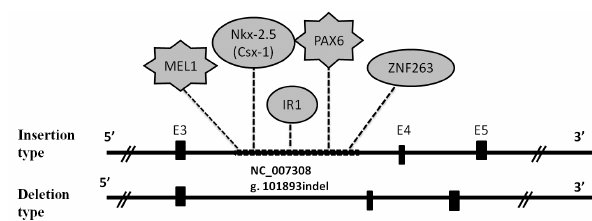
Figure 4. Prediction of transcription factor binding sites in the SMAD3 gene 17 bp indel sequence. MEL1 : MDS1/EVI1 -like gene 1; Nkx-2.5: homeodomain factor Nkx-2.5/Csx; IR1: inhibitive bind- ing sites for glucocorticoid receptor; PAX6 : paired box 6; ZNF263 : zinc finger protein